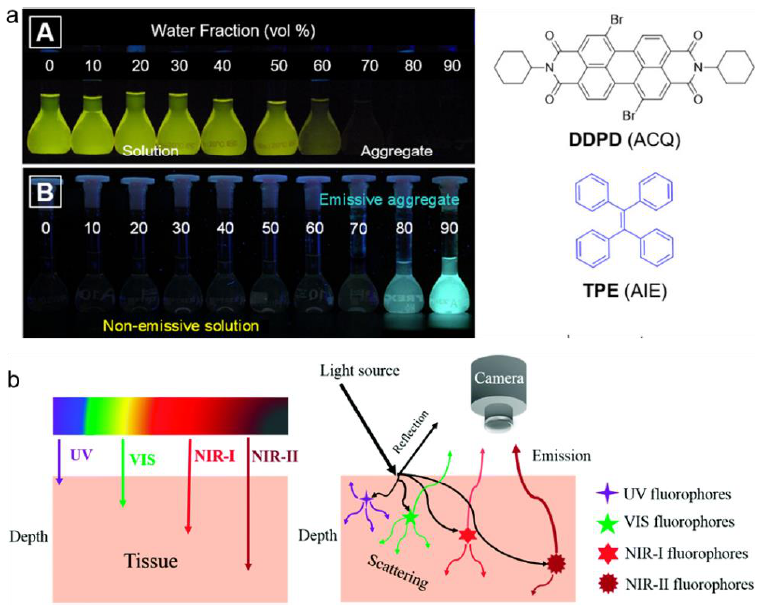
Figure 1. ( a ) Chemical structures of typical ACQ and AIE molecules; and photographs of them in solution and different aggregate states under UV light. DDPD: N , N -dicyclohexyl-1,7-dibromo- 3,4,9,10-perylenetetracarboxylic diimide, TPE: tetraphenylethene (Reprinted with permission from Ref. [43]. Copyright 2018, American Chemical Society). ( b ) Schematic illustration of the penetration depth of different spectral regions and light-tissue interaction (Reprinted with permission from Ref. [63]. Copyright 2018, The Royal Society of Chemistry).